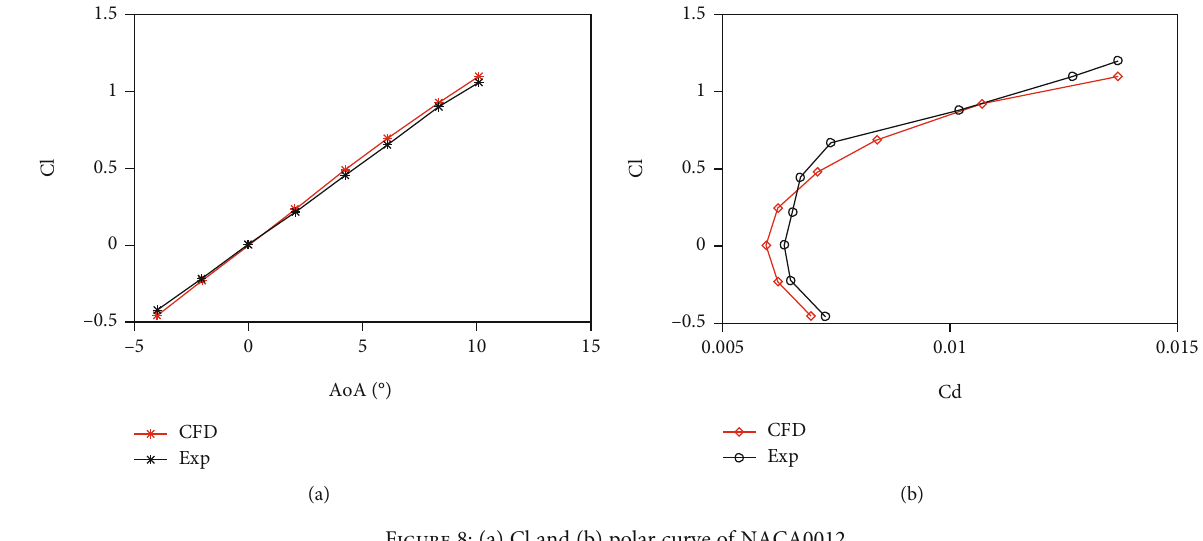
Figure 8: (a) Cl and (b) polar curve of